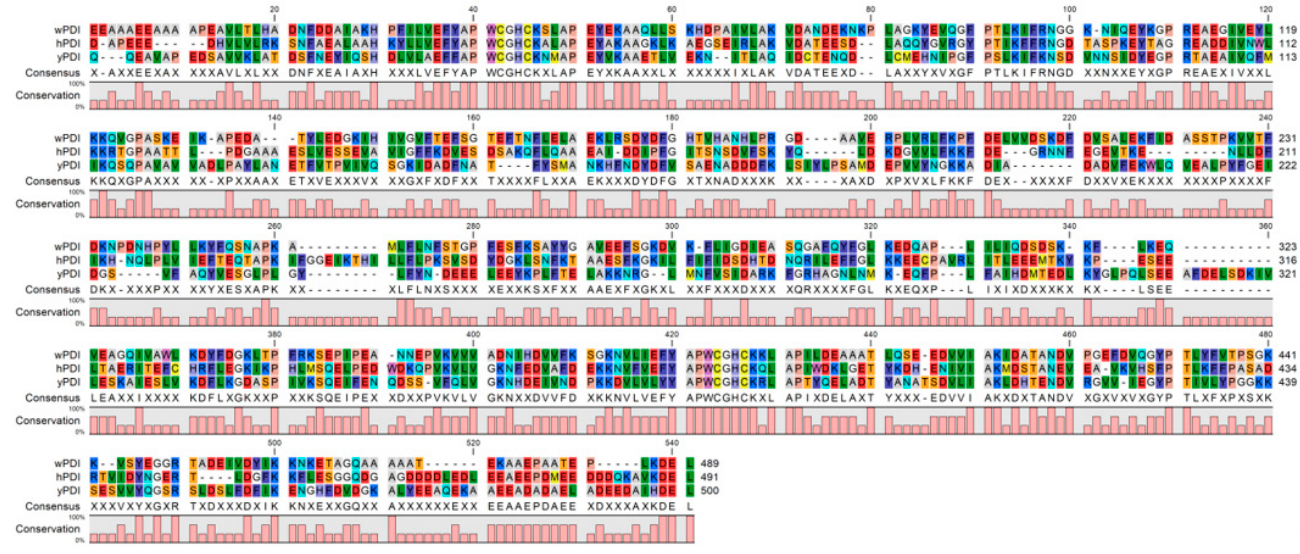
Figure 1. Sequence alignment of wheat protein disulfide isomerase (wPDI) [37], human PDI (hPDI, NCBI: NP_000909.2), and yeast PDI (yPDI, NCBI:P17967.2). Red indicates amino acid residues D, E; yellow indicates C, M; blue indicates R, K; violet indicates F, Y; dark green indicates I, L, V; cyan indicates Q, N; light grey indicates A; tawny indicates P; orange indicates S, T; mauve indicates W; white indicates G; pale blue indicates H.